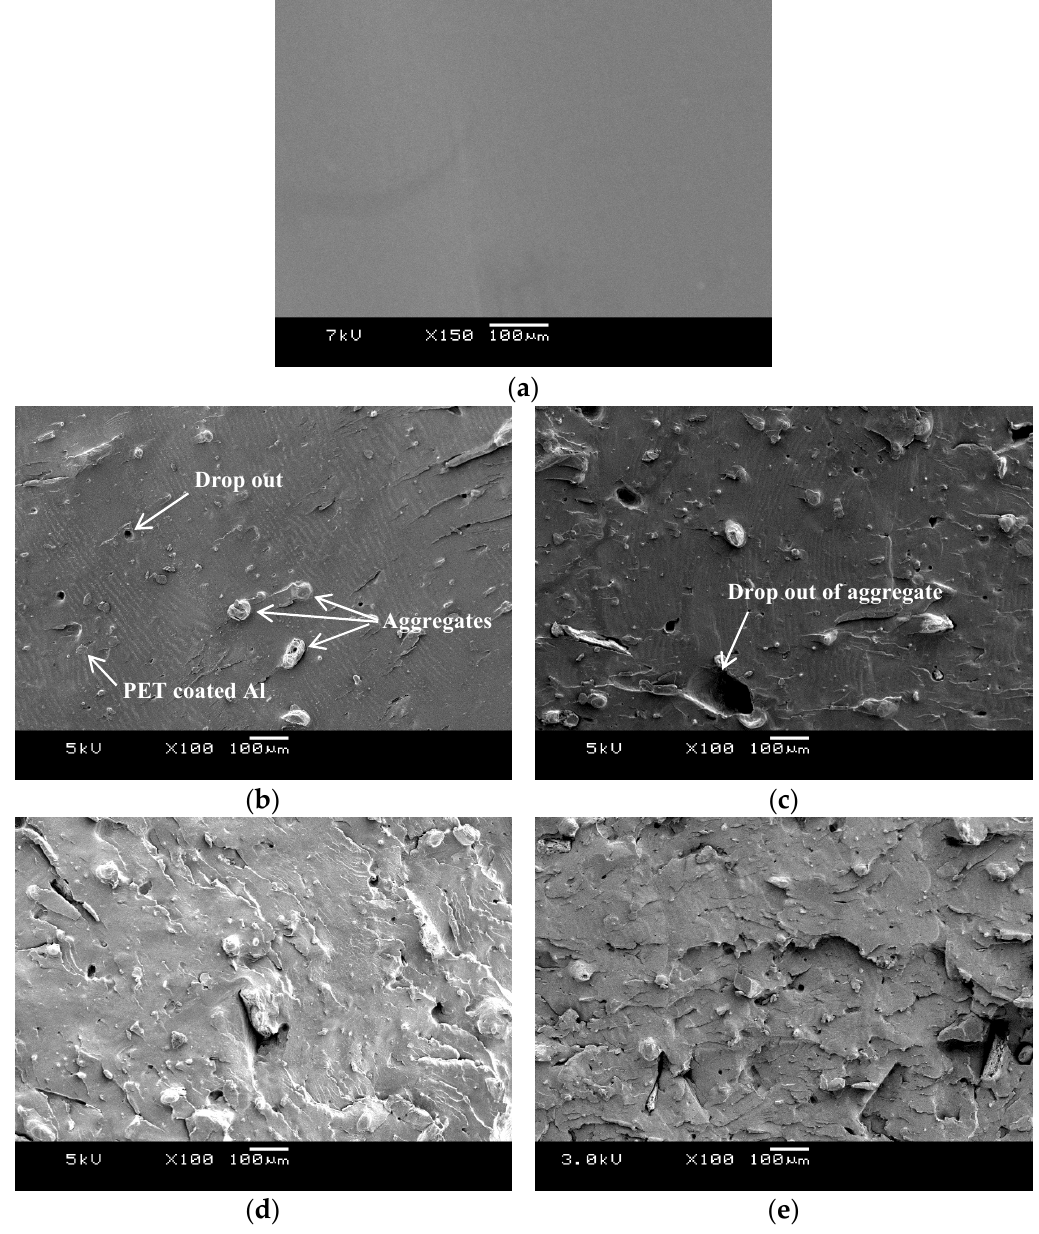
Figure 6. SEM images of (a) Neat PET is featureless. Micro-Al 1/PET composites (b) 5 vol. % Al (c) 10 vol. % Al (d) 15 vol. % Al (e) 20 vol. % Al.